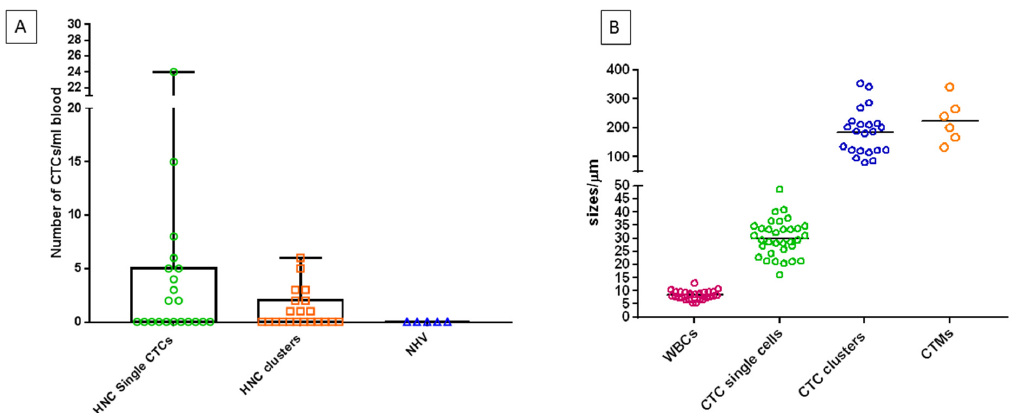
Figure 3. ( A ) The number of CTCs/CTC clusters detected per ml mL blood from HNC patients and normal healthy volunteers (NHV) processed through the straight microfluidic chip. The distribution of single and clustered CTCs/mL is shown and the presence of no CTC-like events in the NHV. ( B ) The size distribution of white blood cells (WBCs), single CTCs and CTC-clusters. Cancers 2019 , 11 , x